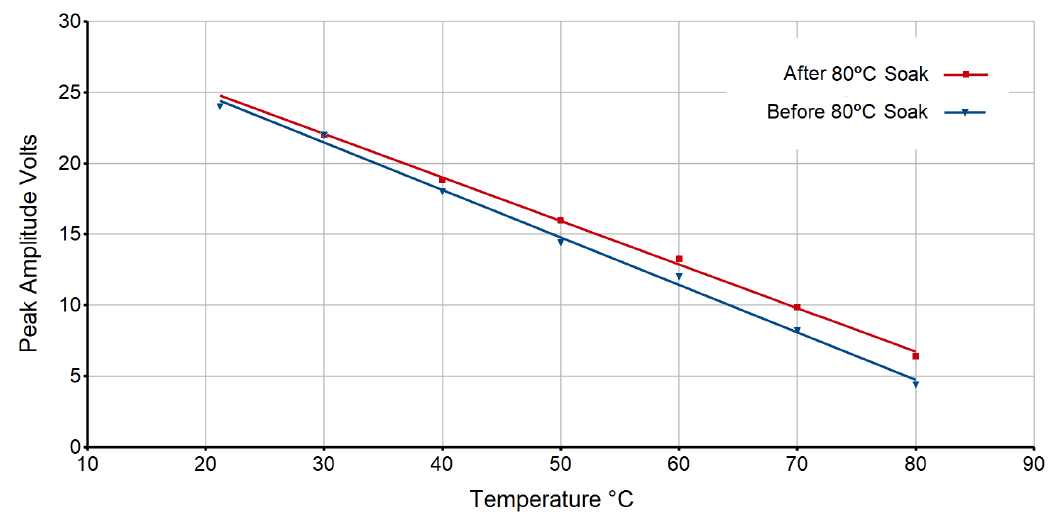
Figure 9. Effect of temperature on peak response before and after 50,000 pressure cycles at 80 ◦